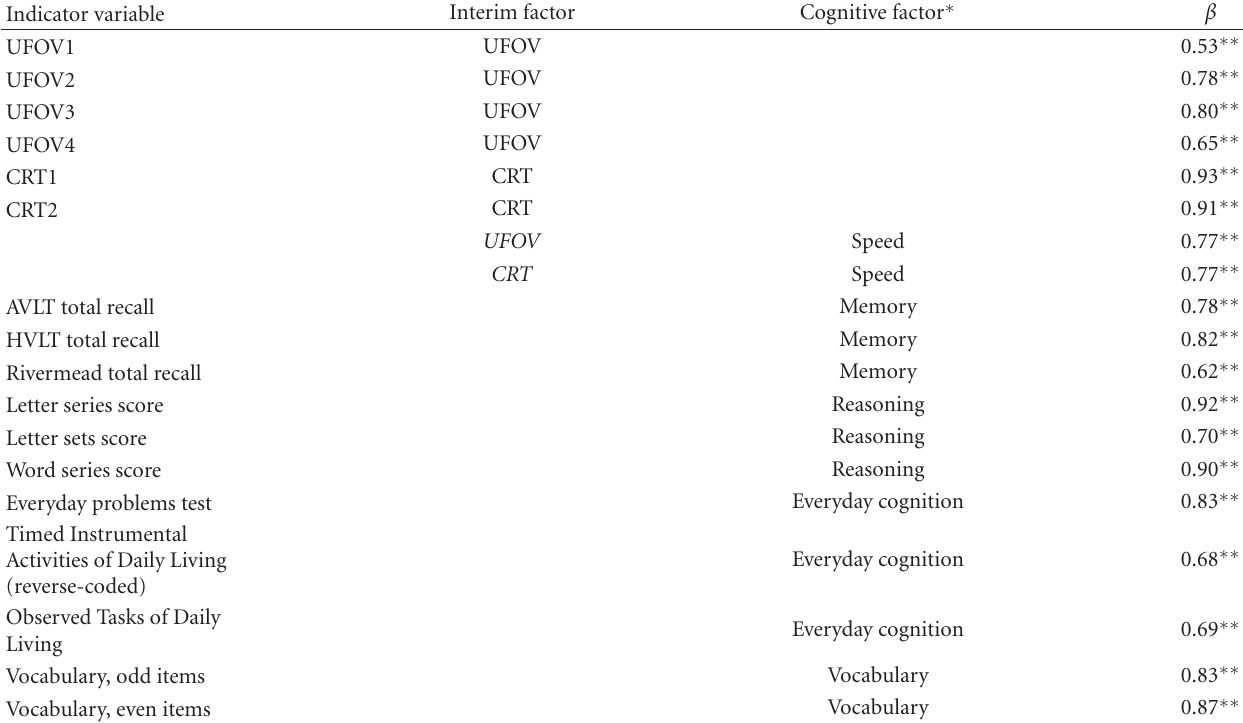
Table 3: Standardized loadings ( β ) of cognitive indicators on first-order cognitive factors. ∗∗ p < 0 . 001 .